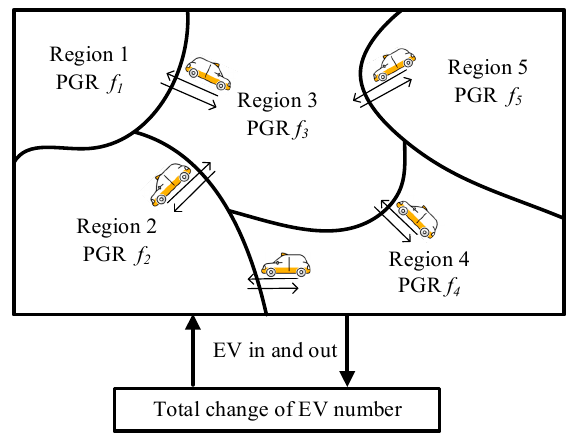
Figure 1. Schematic diagram of mobility of